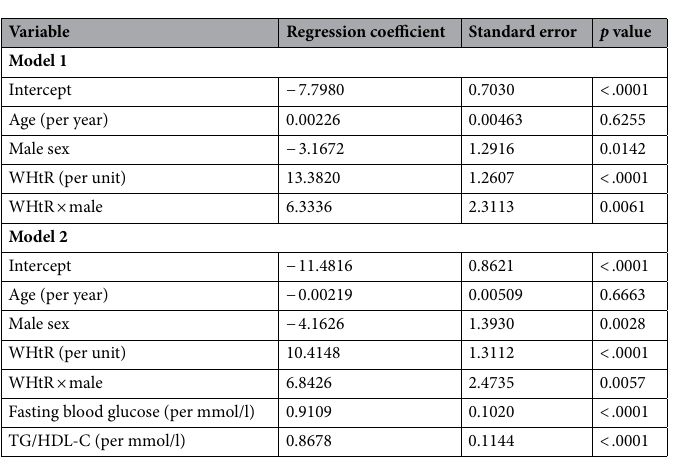
Table 6. Firth logistic regression models for the prediction of insulin resistance (Matsuda index < 4) using WHtR.